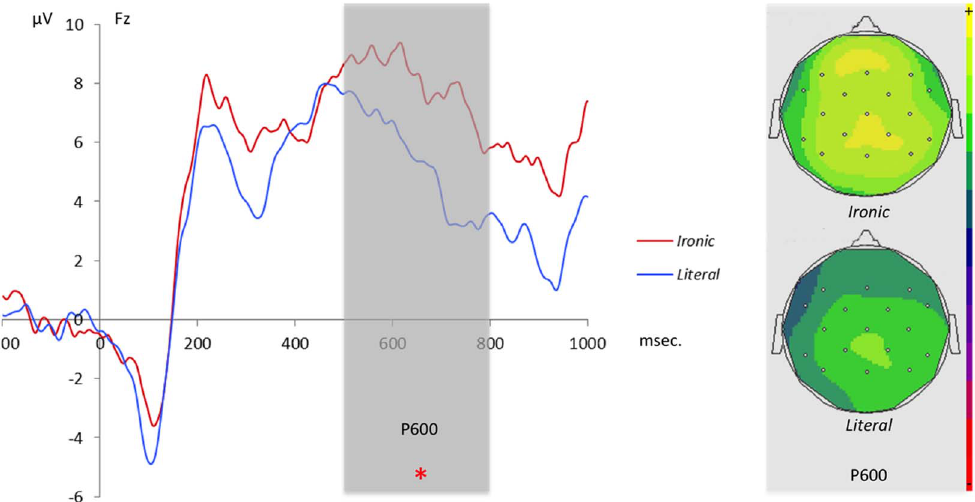
Figure 2. ERP waves for the Ironic (red line) and the Literal (blue line) conditions at Fz. The gray rectangle highlights the interval at which point the difference between the Ironic and the Literal condition is significant. On the right are the scalp distributions for both conditions at the peak of the P600 effect.